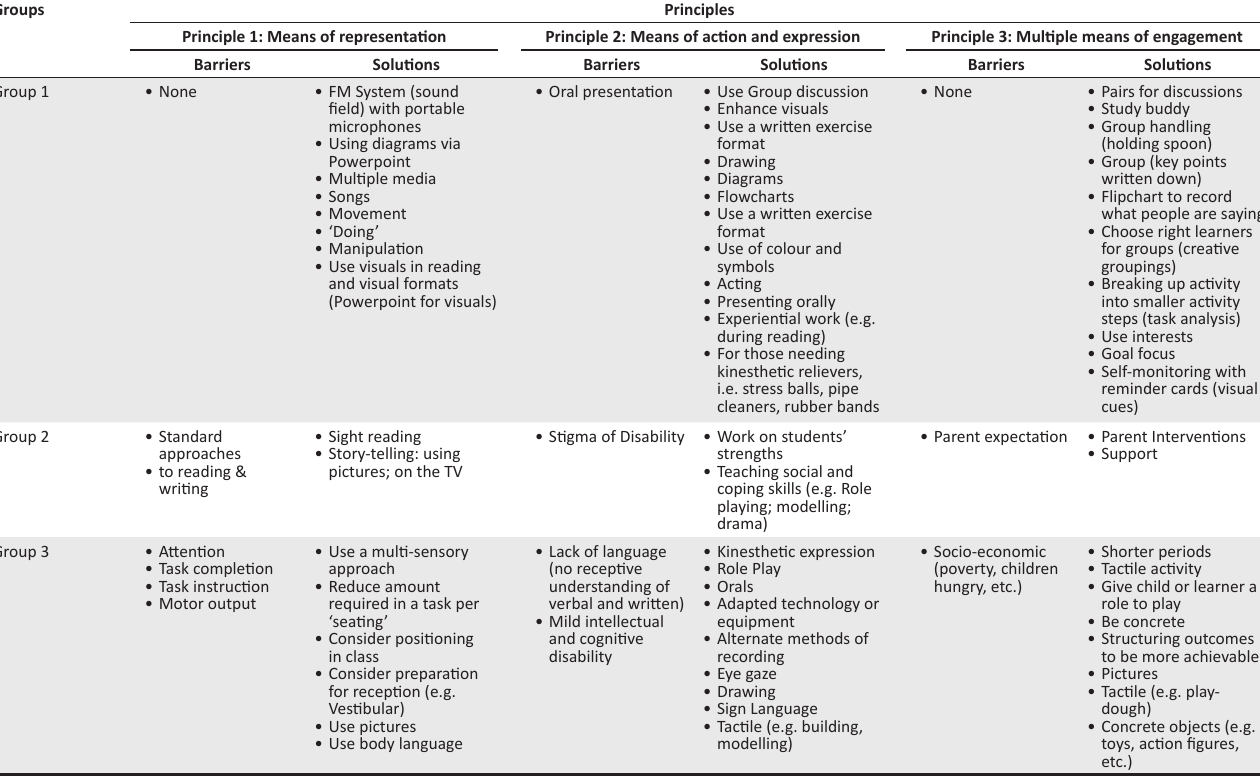
TABLE 1: Universal Design for Learning Barriers and Solutions.